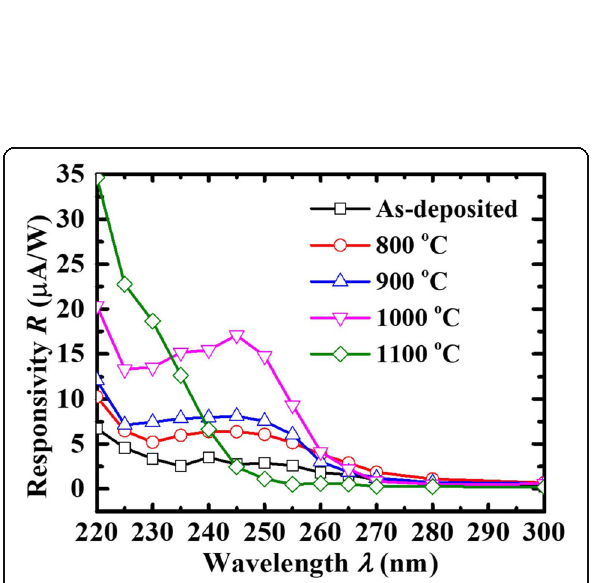
Fig. 8 a Time-dependence of photoresponse characteristics b rise and decay